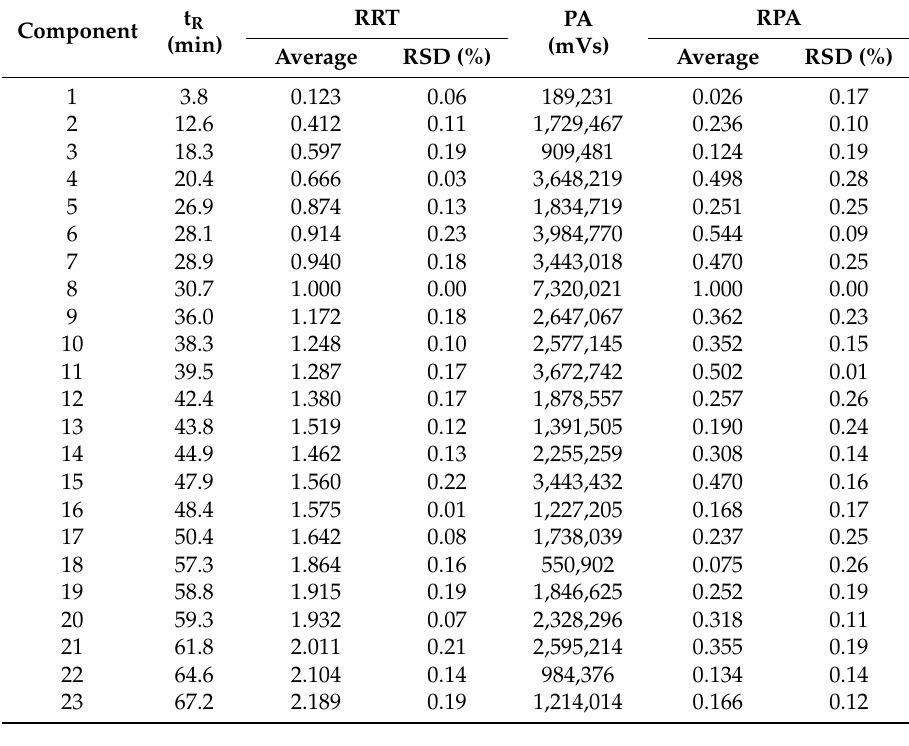
Table 3. The retention time (t R ), the relative retention time (RRT), the peak area (PA), and the relative peak area (RPA) of 23 common peaks in R. rugosa ( n = 10).